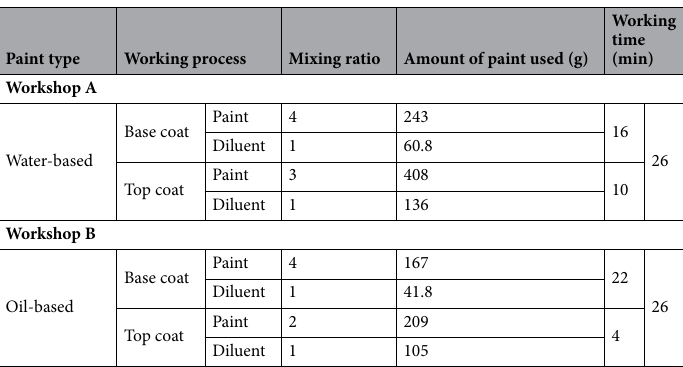
Table 2. Characteristics of two different auto-repair painting